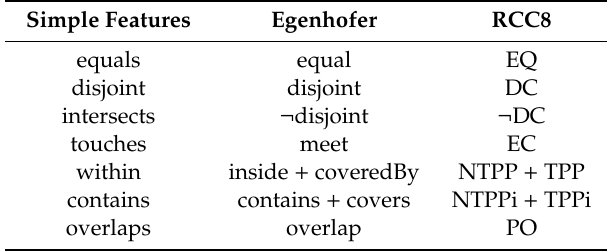
Table 1. The equivalency relationships between simple features, Egenhofer, and RCC8.